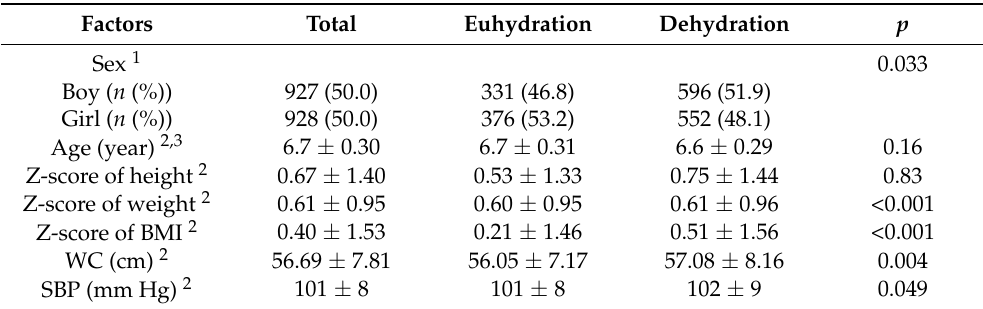
Table 1. Descriptive characteristics of 7–8 years old children categorized by hydration status in Beijing, China ( N =